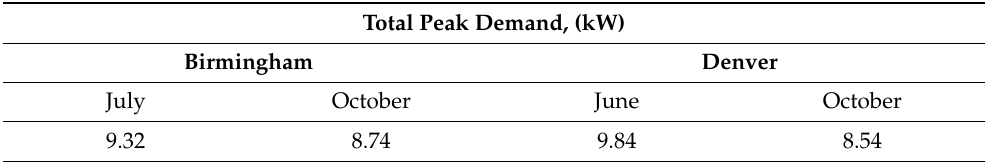
Table 7. Total household peak demand for all wall types